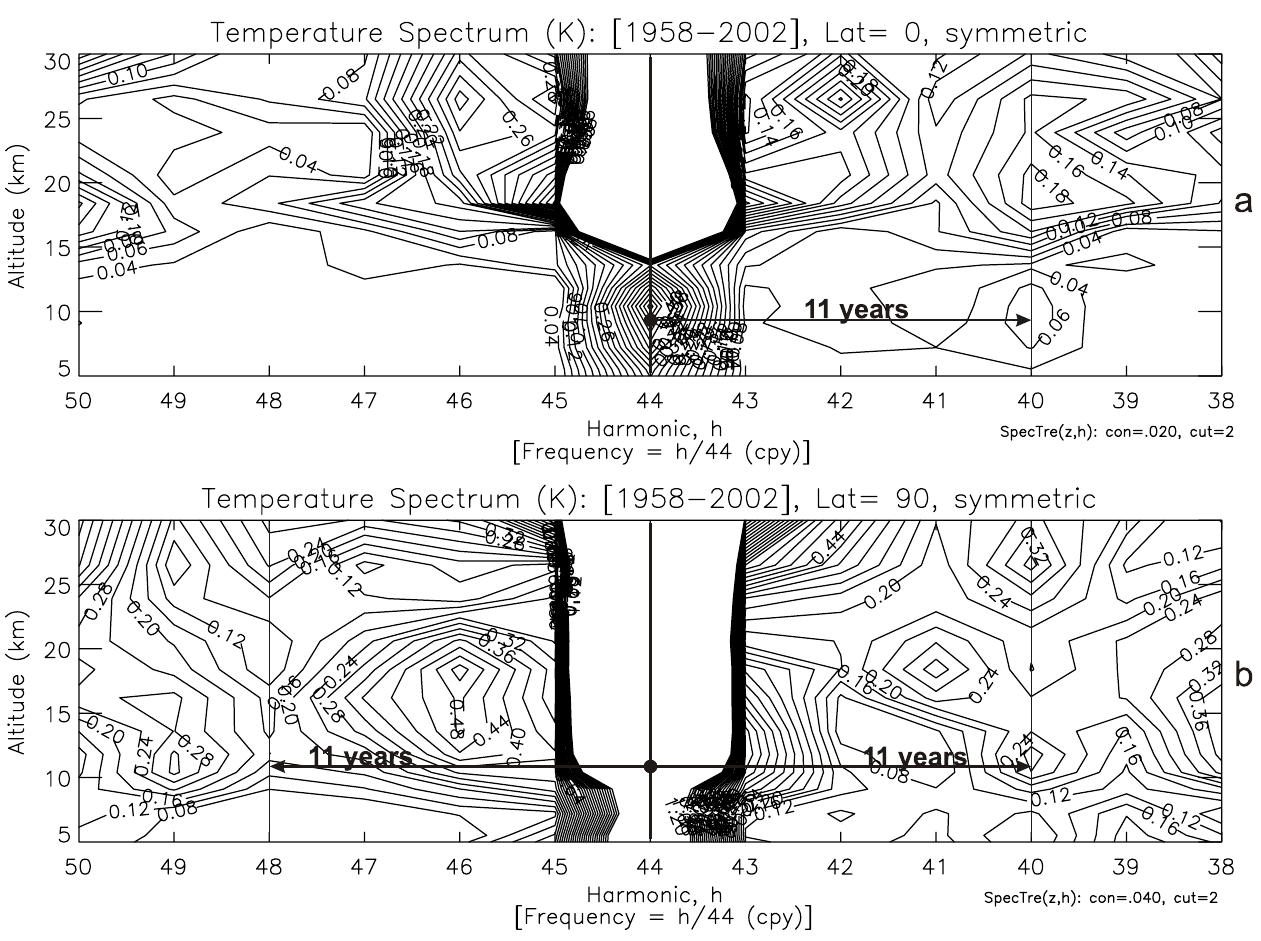
Fig. 4. Amplitude spectra are shown, covering 44 years from 1958–2002 for the hemispherically symmetric NCEP/NCAR Re-1 temperatures at the equator (a) and pole (b) . With contour intervals of 0.02K (a) and 0.04K (b), the 12-month oscillation amplitudes at h=44 are saturated. Weak signatures of the 11-year modulation are evident at h=40 (44 − 4) in (a) and at h=44 ± 4 in (b). The spectra for the subsequent 44-year windows, starting in 1959 and shifted by one year, show similar